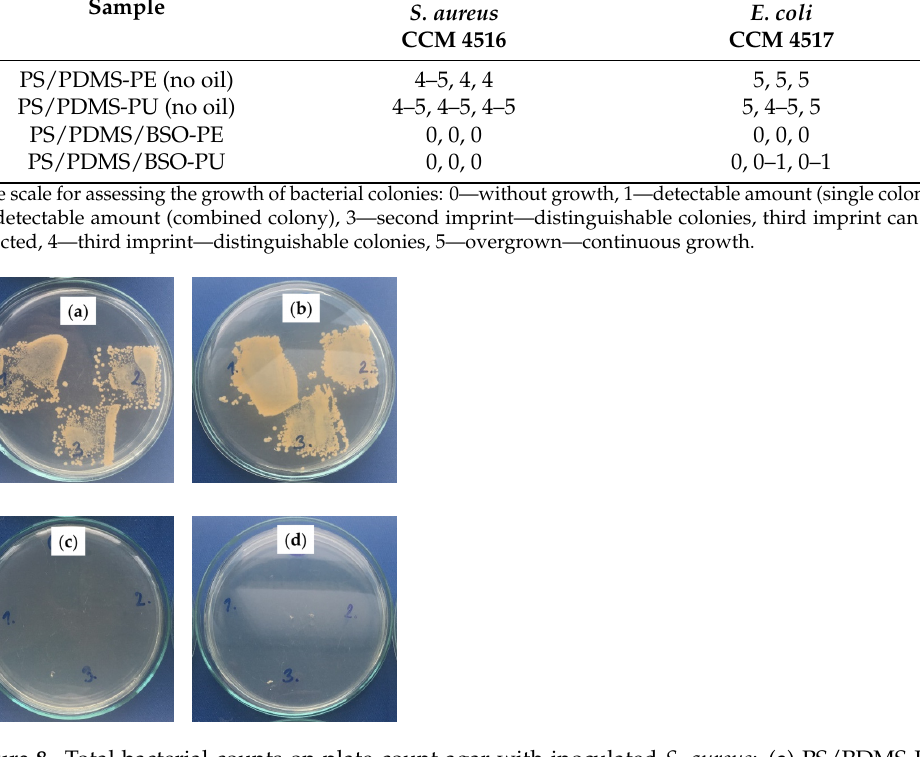
Figure 8. Total bacterial counts on plate-count agar with inoculated S. aureus : ( a ) PS/PDMS-PE, ( b ) PS/PDMS-PU, ( c ) PS/PDMS/BSO-PE, ( d ) PS/PDMS/BSO-PU; numbers represent various imprint locations.